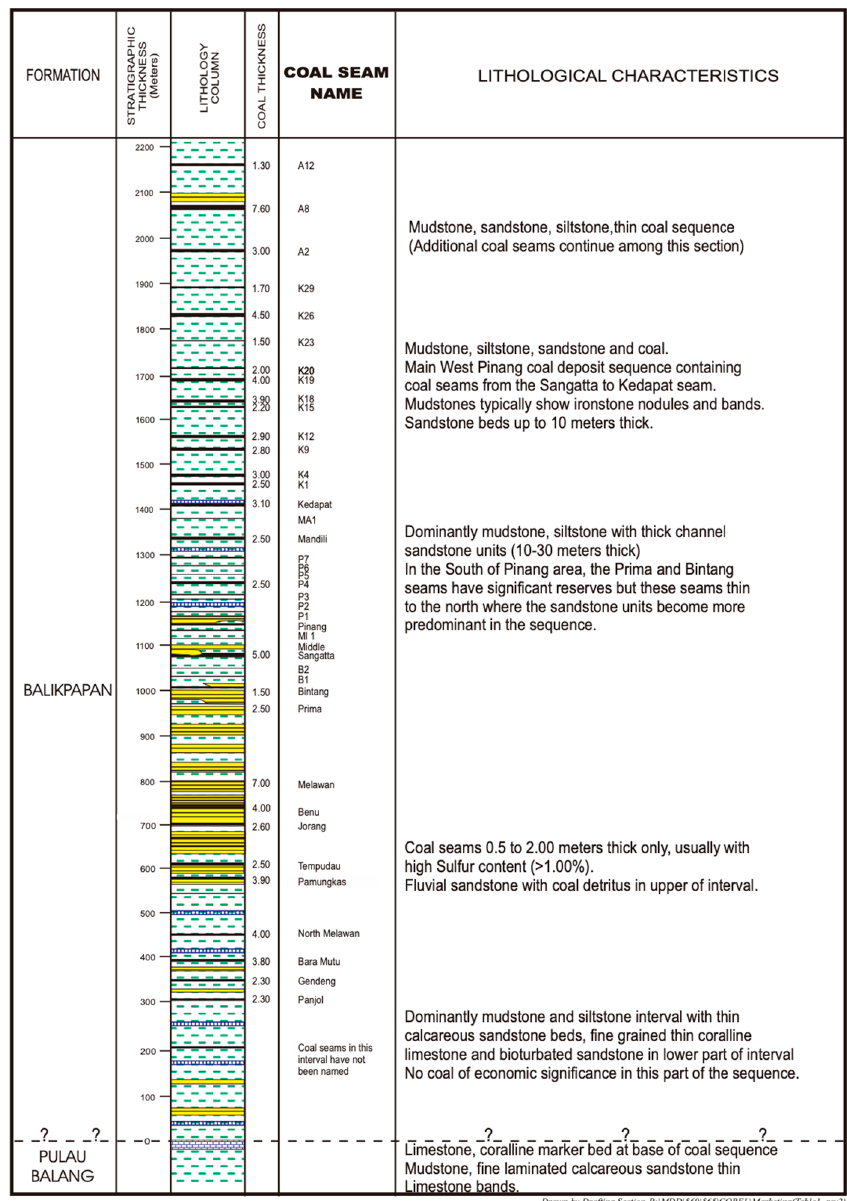
Figure 2. Stratigraphy of study area.